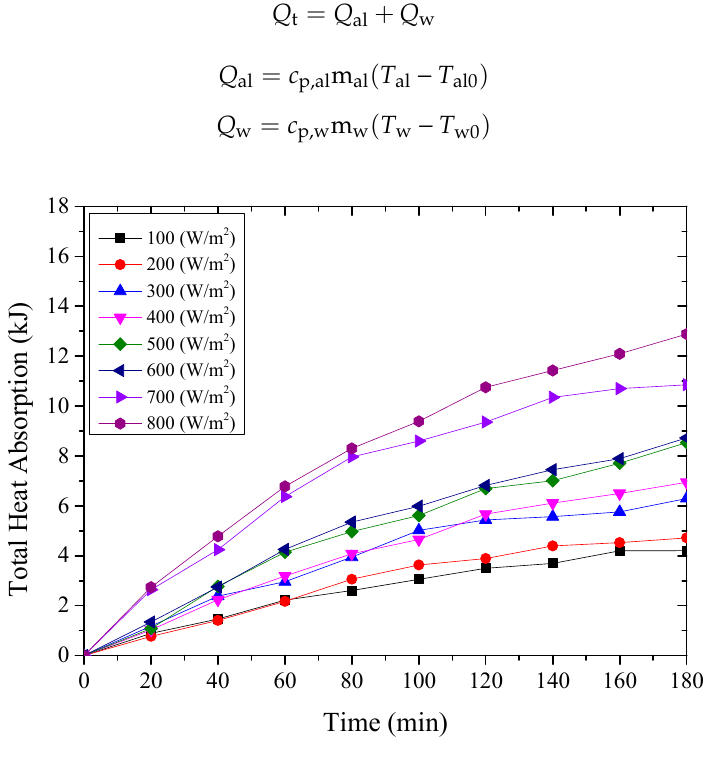
Figure 11. The amount of heat absorbed by the polished aluminum sheet.